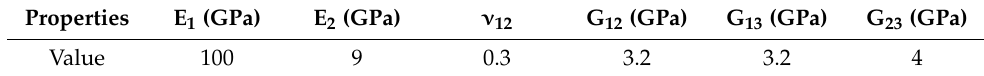
Table 2. Elastic properties of GRP